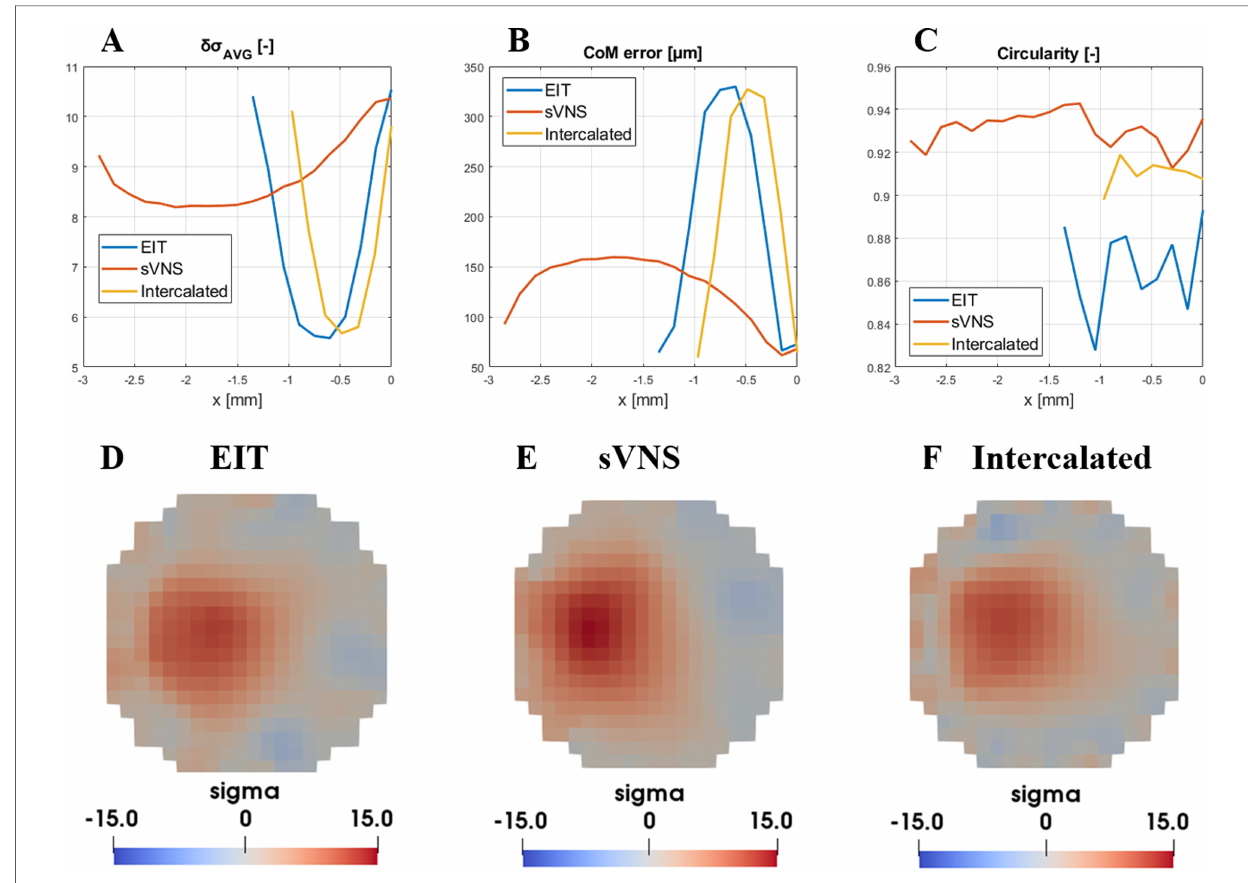
FIGURE 3 Evaluation of fi gures of merit (( A ) δσ AVG , ( B ) CoM and ( C ) circularity) for the EIT, sVNS and intercalated array geometries. For each geometry, circumferential nerve area below the electrodes is divided into multiple cross-sections with single-voxel resolution and fi gures of merit are evaluate over each one along the longitudinal direction. For this reason, geometries with longer electrodes such as the sVNS design have longer pro fi les. ( D – F ) Image reconstruction results for each geometry at the location of maximum signal intensity and lowest CoM localisation error, identi fi ed by data in top row. Images are shown for the perturbation centred at 500 µm from the centre and with a scale representative of the maximum value reached across all